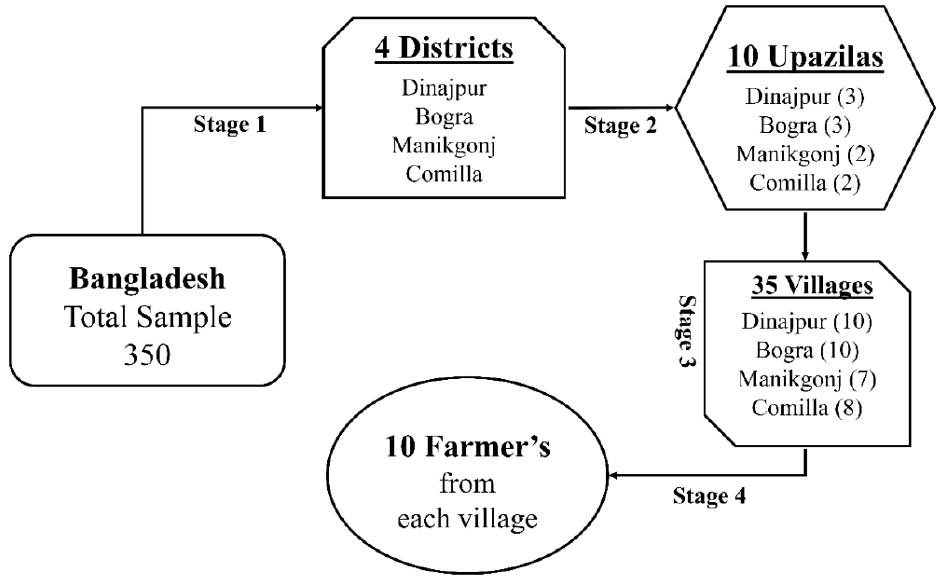
Figure 3. Survey design.